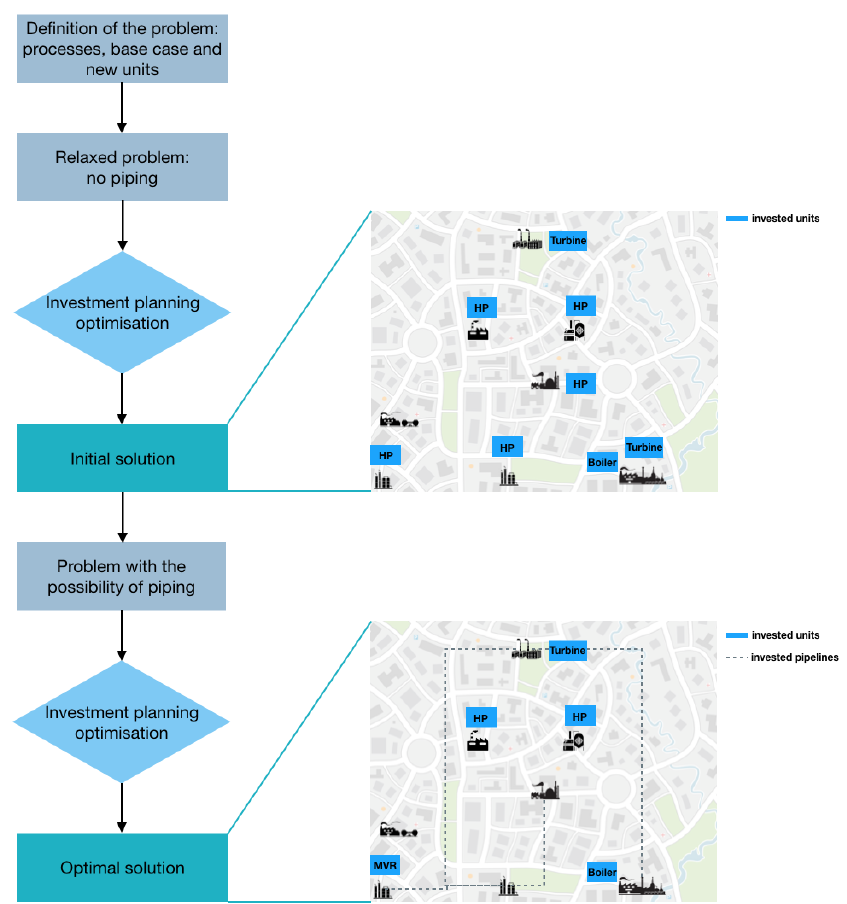
Figure 3. Strategy for solving the problem in two steps; initialisation and